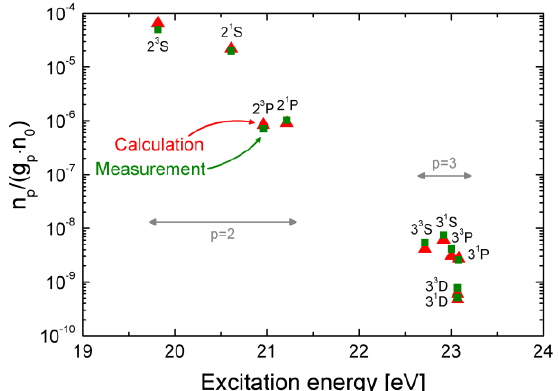
Figure 2. Line-of-sight averaged population densities n p for electronically excited states of He measured by optical absorption (p = 2) and emission (p = 3) spectroscopy and results of calculations using the Yacora collisional radiative (CR) model for He. The population densities are divided by the statistical weight of the states and normalized to the ground state density n 0 of He.